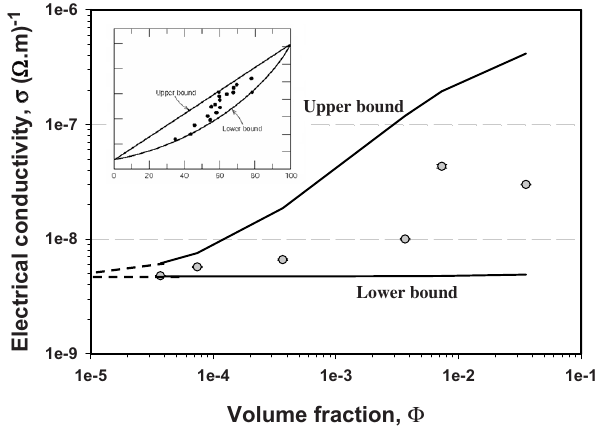
Fig. 5. Electrical conductivity versus volume fraction of NR-STR5L/PZ 5 composite compared to the upper bound and lower bound limitation of the mixture rule.